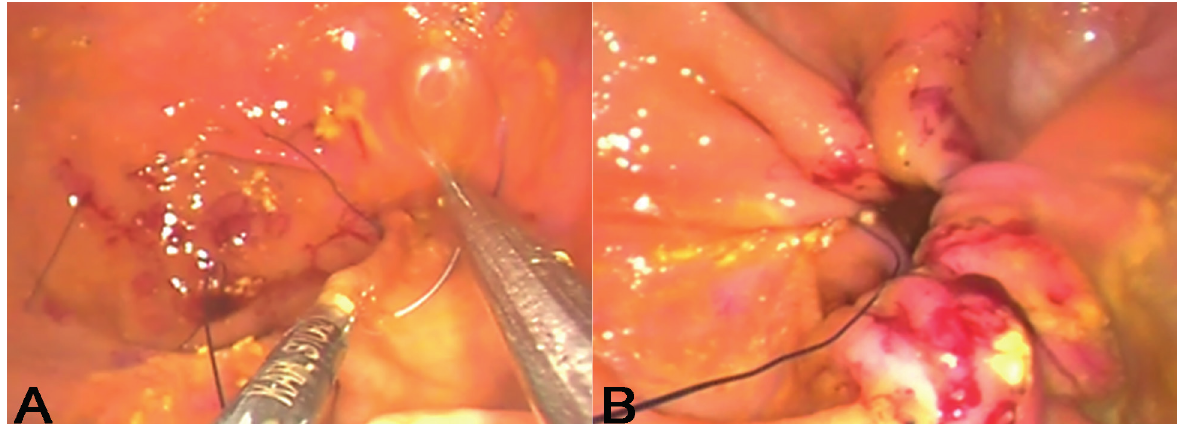
Figure 3 - Single-port Intragastric Sleeve in pigs. a ) Needle passing through the mucosa and submucosa of stomach. b ) Traction of surgical thread for making the suture in tobacco pouch (final appearance).